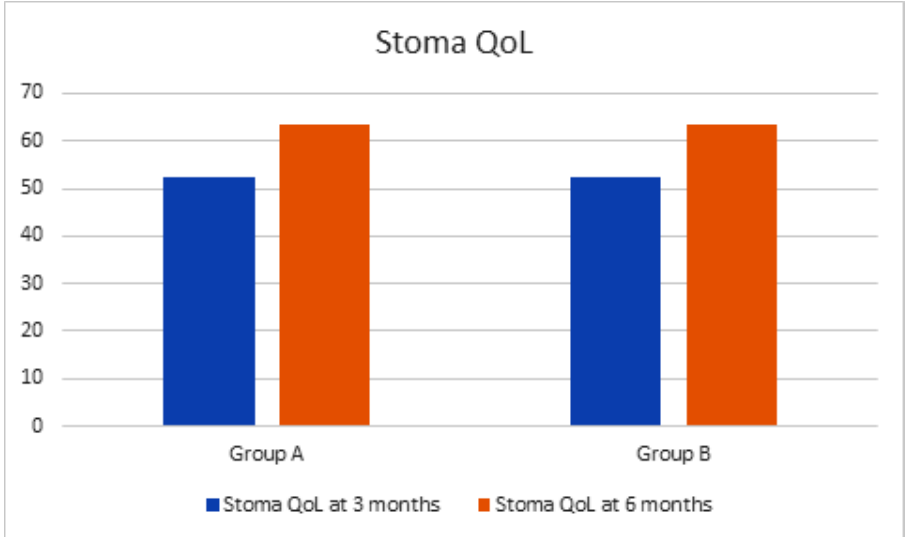
Figure 2. Stoma Quality of Life at 3 and 6 months of follow-up after surgery. QoL: Quality of Life.